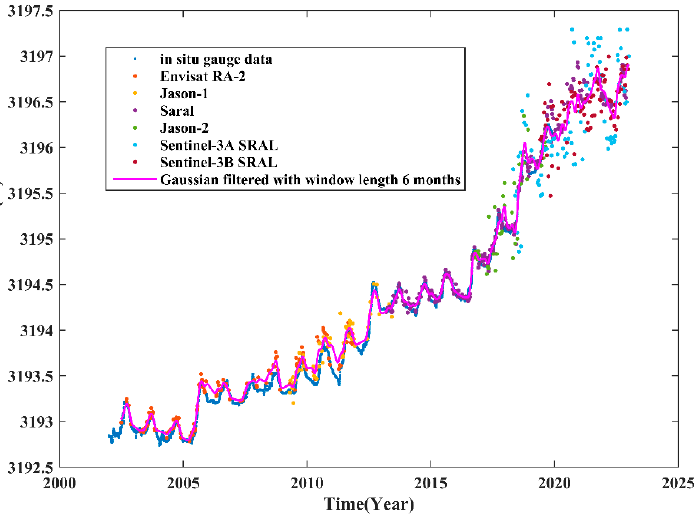
Figure 11. Comparison between the reduction results of this paper for each satellite in the middle position and the hydrological gauge data from the Xiashe station.